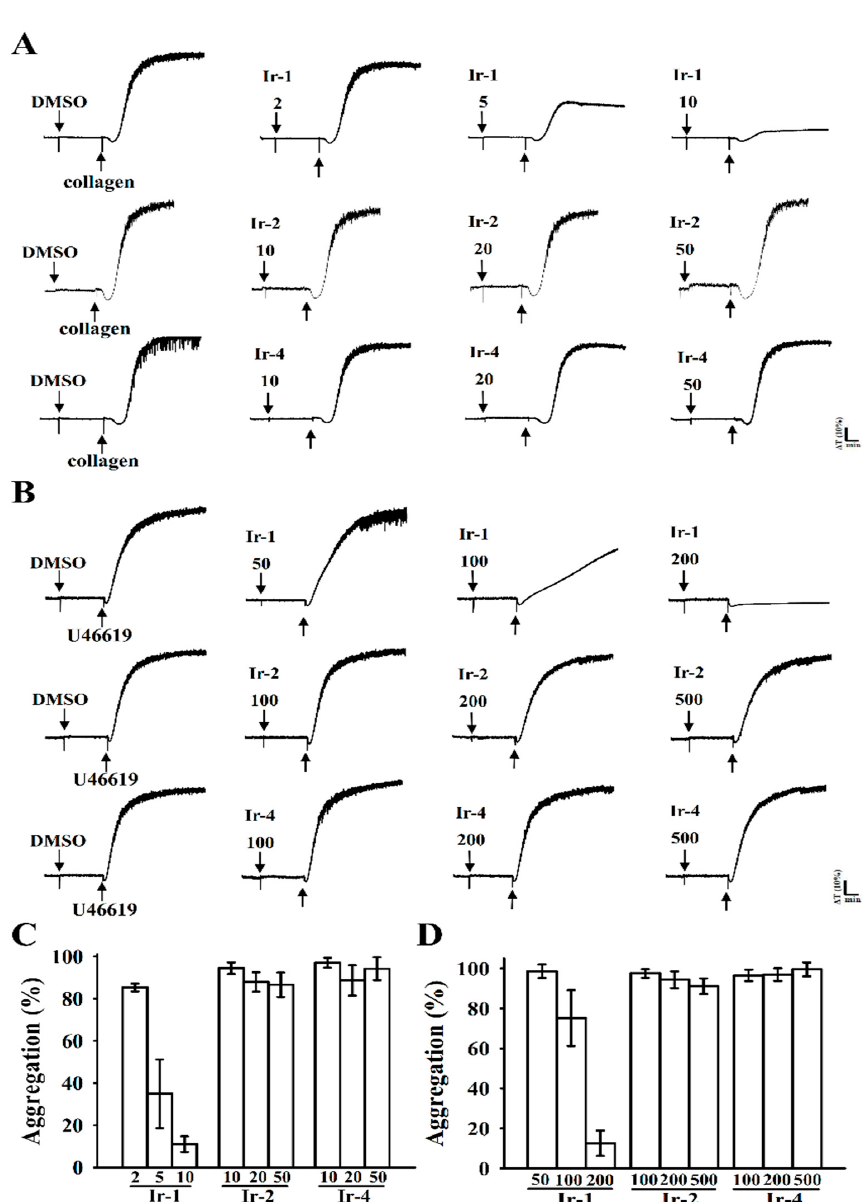
Figure 2. Anti-aggregation activity of iridium complexes (Ir1, Ir-2 and Ir-4) on collagen and U46619- induced platelet aggregation in washed human platelets. ( A ) Washed human platelets (3.6 × 10 8 cells/mL) were preincubated with the solvent control (0.1% DMSO) or Ir-1 (2–10 μ M), Ir-2 and Ir-4 (10–50 μ M) for 3 min and then treated with 1 μ g/mL collagen for 6 min; ( B ) Washed human platelets were preincubated with the solvent control or Ir-1 (50–200 μ M), Ir-2 and Ir-4 (100–500 μ M) for 3 min and then treated with 1 μ M U46619 for 6 min to stimulate platelet aggregation. Histograms of